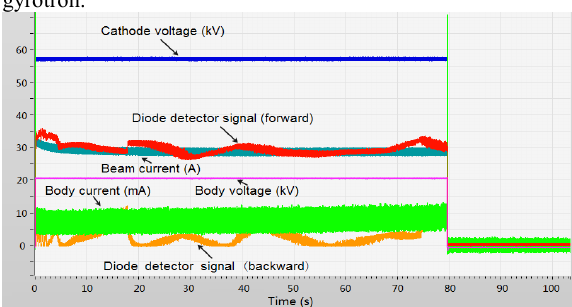
Fig. 8. The waveforms of the 500W 80s pulse of the #2 gyrotron.